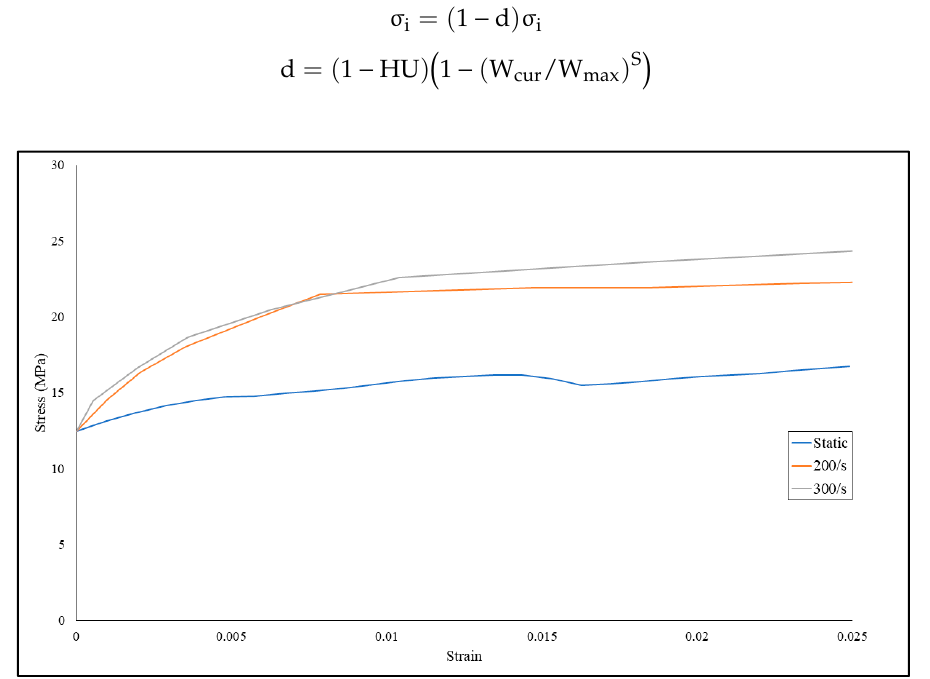
Figure 8. Plastic stress–strain curve input on strain rate value of 200/s and 300/s for dry jellyroll model.